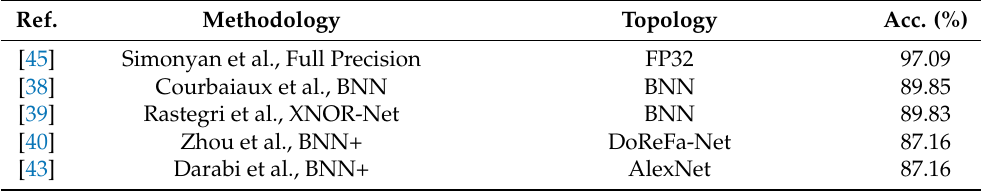
Table 2. Accuracy of different methodologies on the CIFAR-10 database.